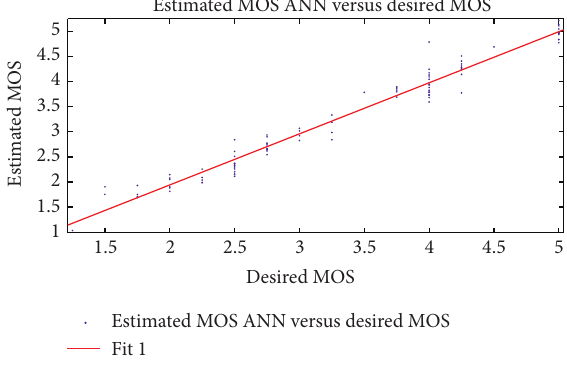
Figure 9: Estimated ANN MOS versus expected